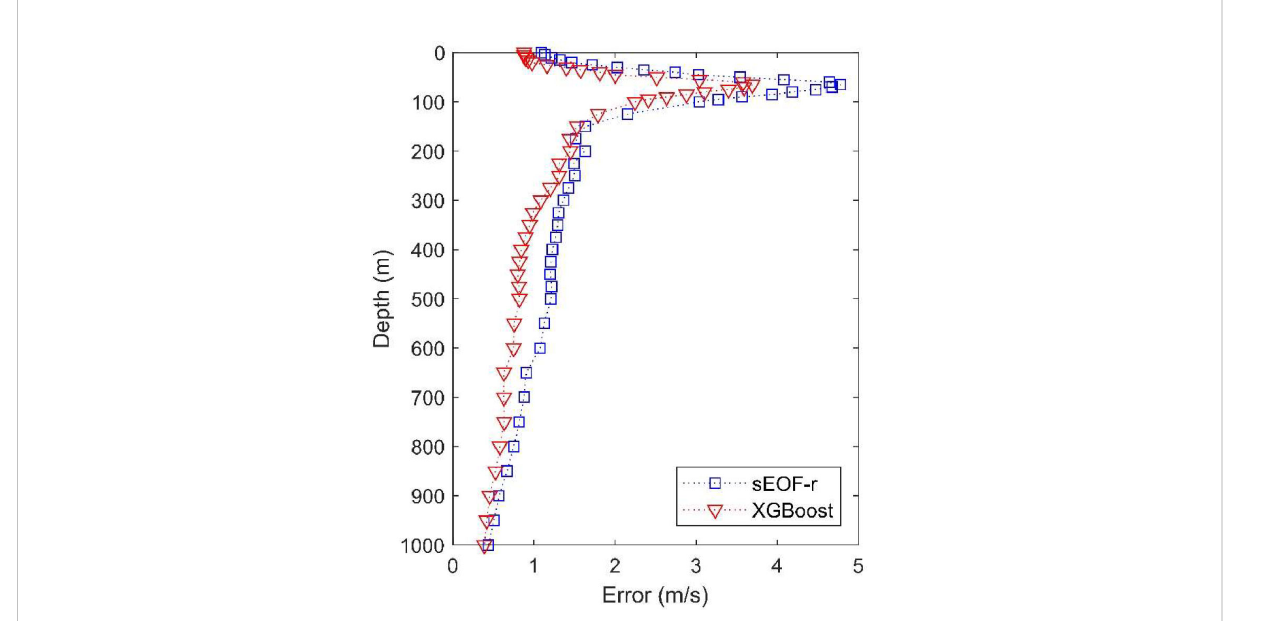
FIGURE 5 Reconstruction errors of the sEOF-r and XGBoost models at different depths.